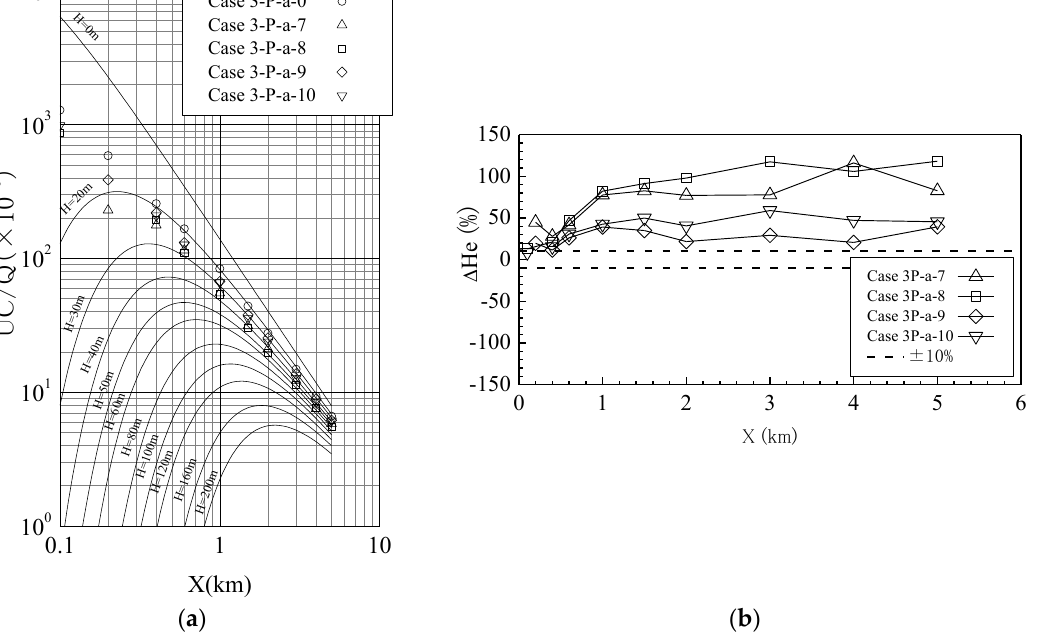
Figure 3. Examples of results of wind-tunnel experiments for PWR site. ( a ) Ground concentrations; ( b ) Relative change in effective stack height.